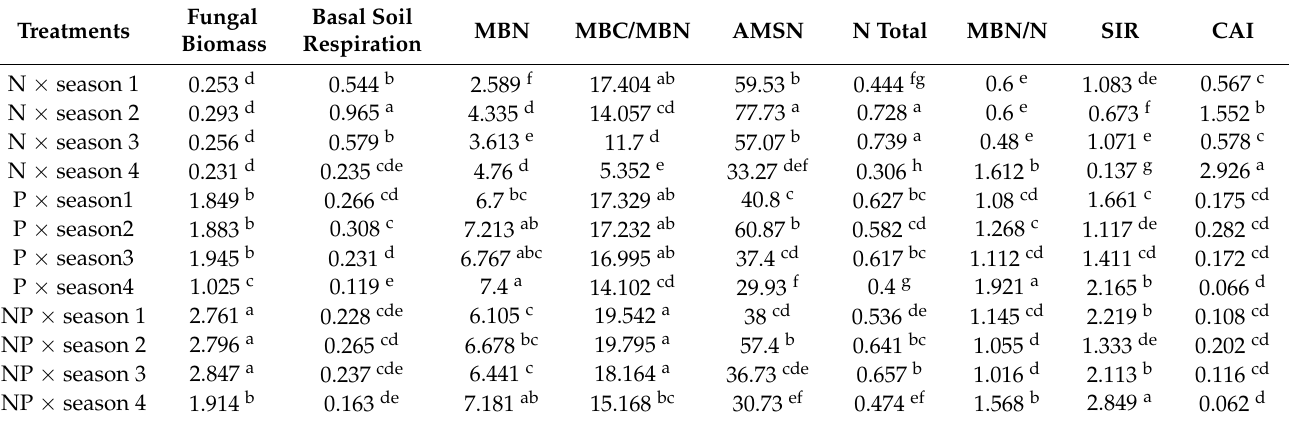
Table 5. Comparison of means for interaction effects of grazing managements and season treatments.